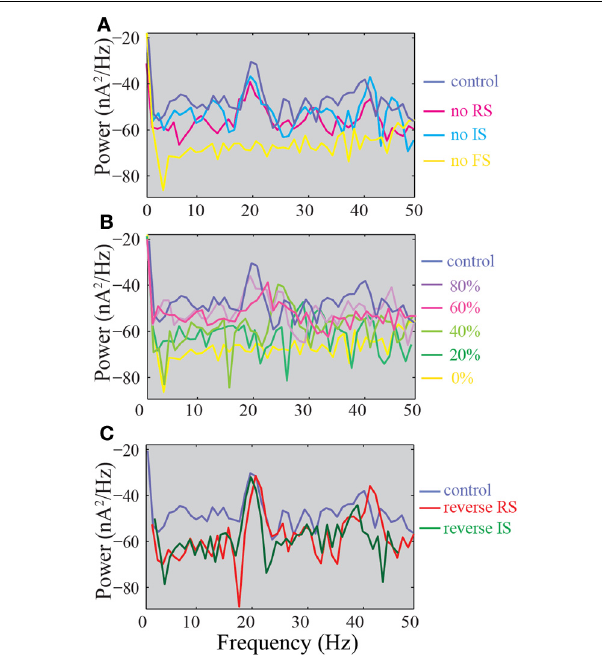
FIGURE 10 | Power spectra of the summed synaptic activity in the model network. (A) Power spectra of the control, FS KO, RS KO, and IS KO networks. (B) Power spectra of networks with different % of remaining FS inputs on pyramidal models. (C) Power spectra of the control compared to reverse RS and reverse IS